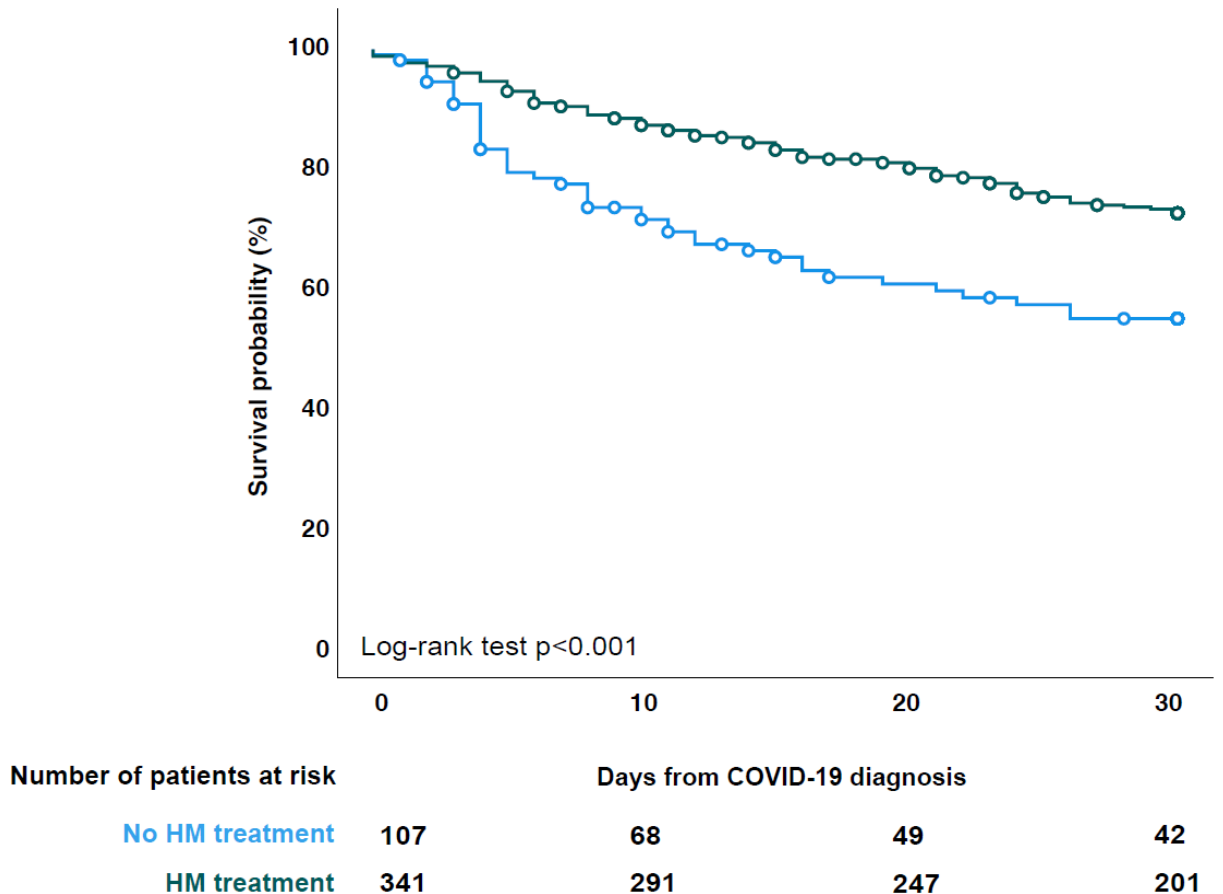
Figure 2. 30-day survival probability of treated vs. untreated patients. Table 3. Univariable and multivariable analysis for risk factors for mortality (whole